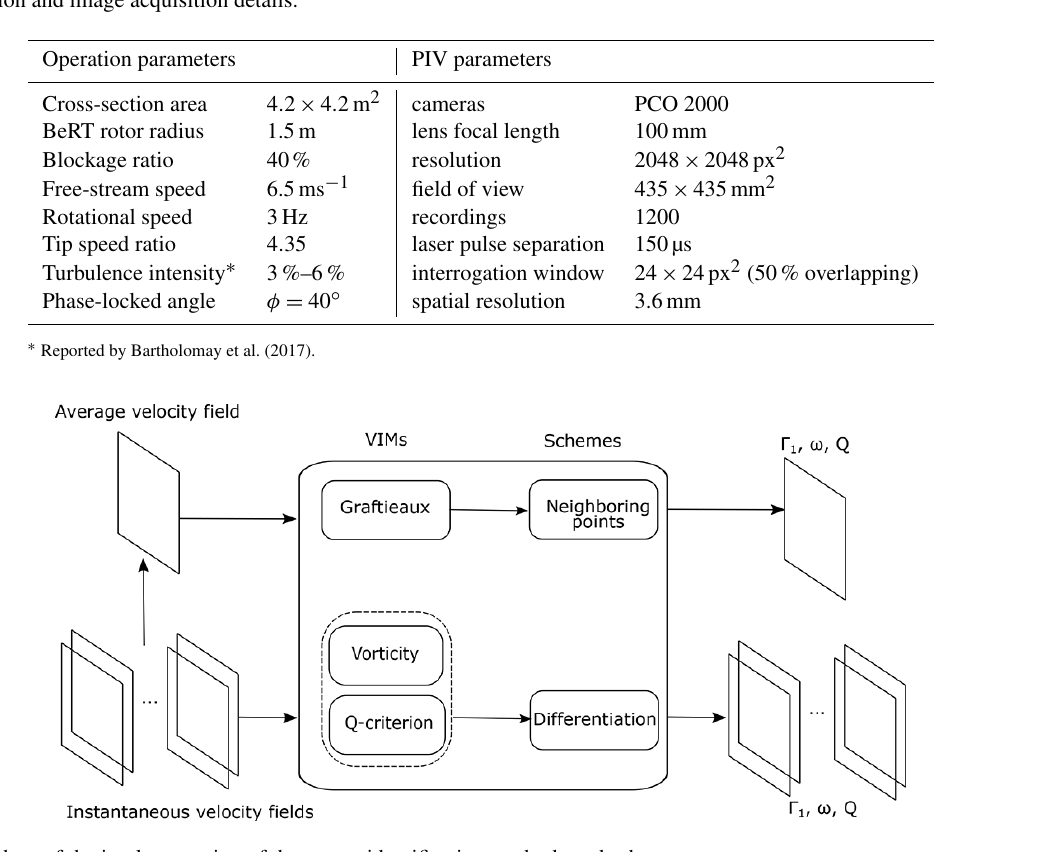
Figure 3. Flowchart of the implementation of the vortex identification methods and schemes.